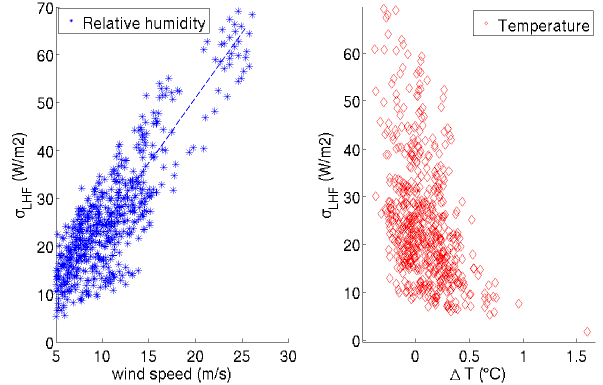
Figure 12. Uncertainty propagation into the latent heat flux from measurements uncertainties via profile calculations. (a) Propagated uncertainties into LHF versus wind speed: results of a Monte Carlo experiment starting with an error of ± 2.5% for relative humidity (blue square). (b) Propagated uncertainties into LHF versus tem- perature gradients (difference between level 5 and level 2). Results of a Monte Carlo experiment starting with an error of ± 0.35 ◦ for temperature (red